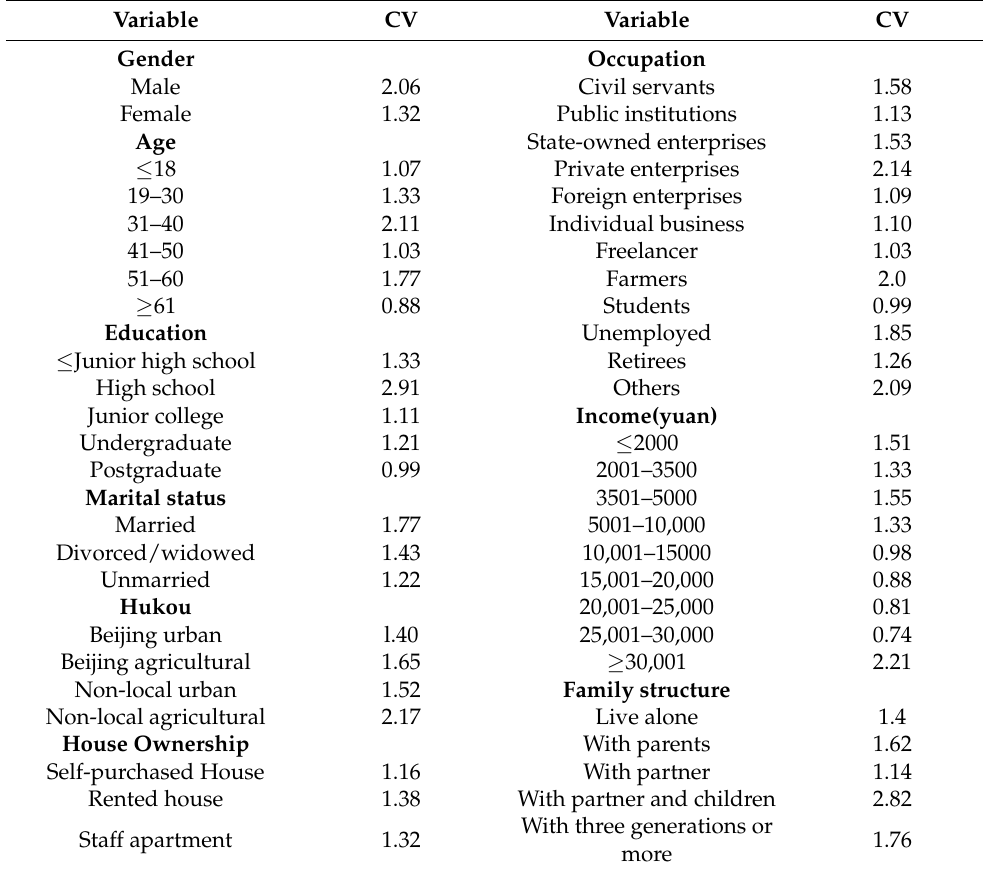
Figure A1. Coefficient of variation of different activities. Table A7. Coefficient of variation of residents in all